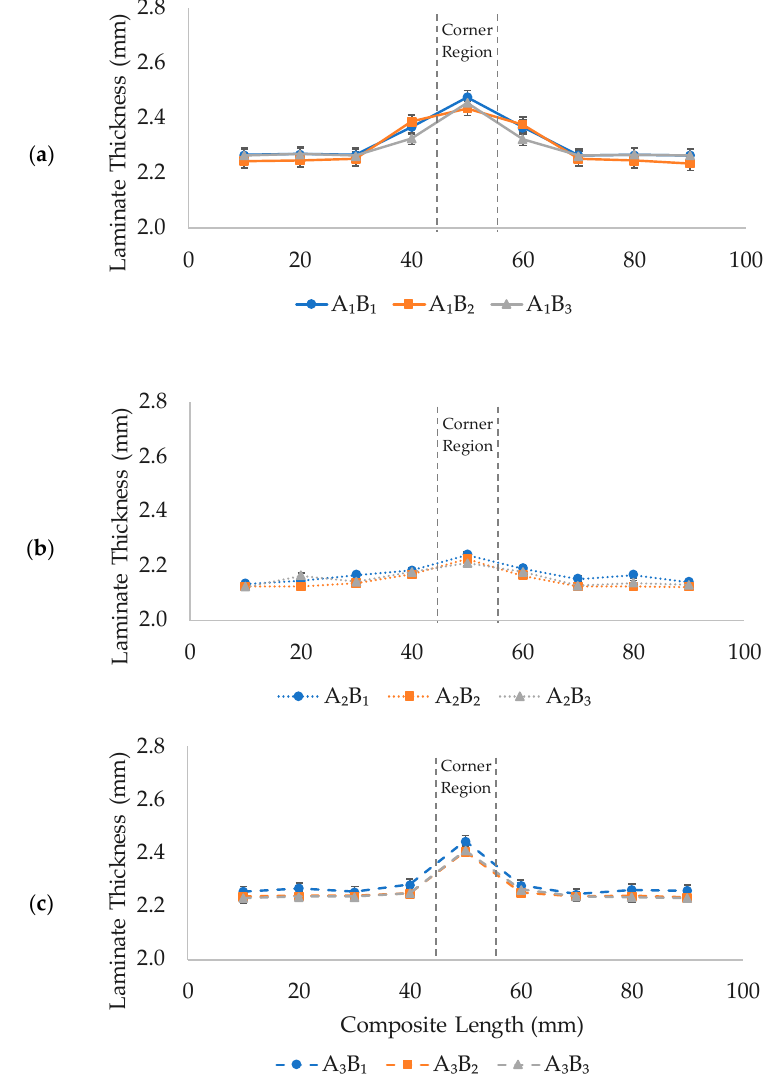
Figure 6. Thickness across the length of laminates with concave corner produced using ( a ) SVB, ( b ) MSVB, and ( c ) DVB techniques.